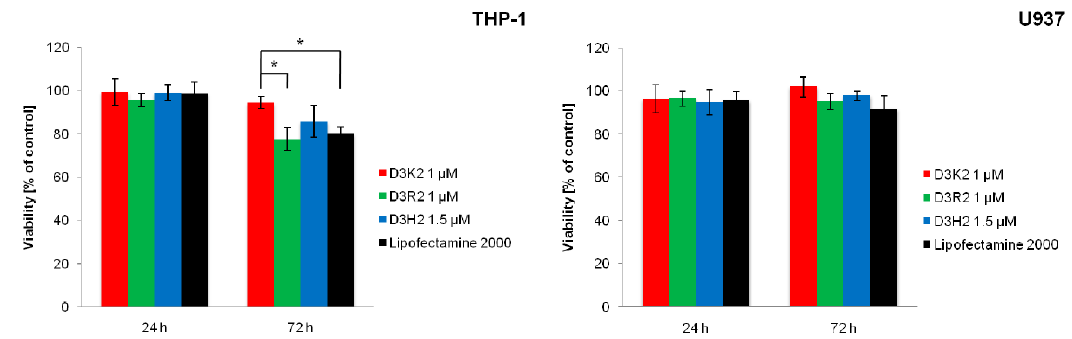
Figure 4. The effect of dendriplexes on the viability of THP-1 and U937 cell lines, presented as a percentage of untreated control (average ± SD, n = 3). The dendrimer:siRNA molar ratios equaled 20:1 (D3K2, D3R2) and 30:1 (D3H2). * Statistically significant difference at p < 0.05.